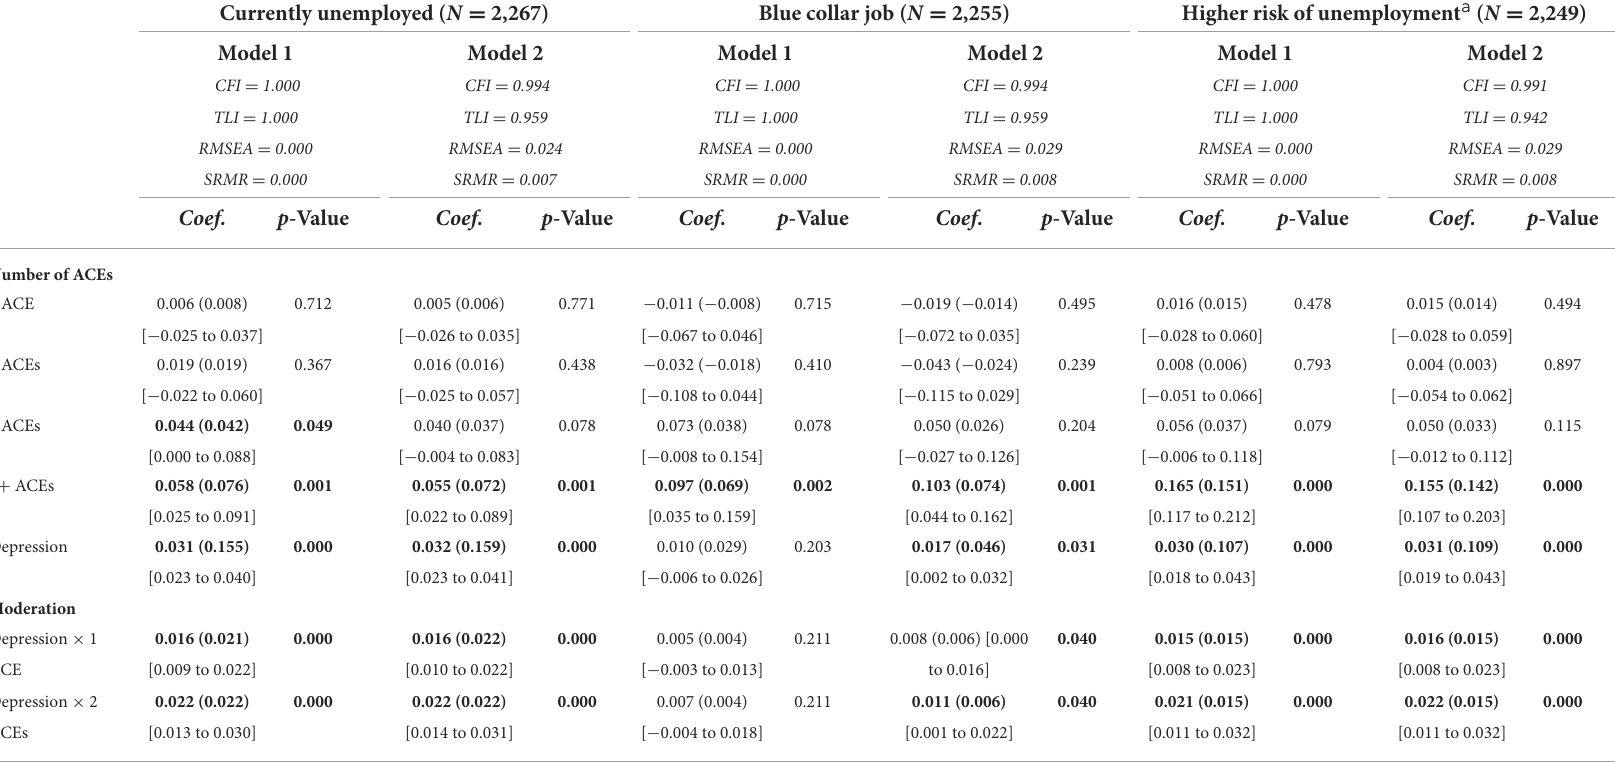
TABLE 4 Results of the structural equation models for current unemployment, blue collar employment and higher risk of unemployment with 95% confidence intervals. Currently unemployed ( N = 2,267) Blue collar job ( N = 2,255) Higher risk of unemployment a ( N =